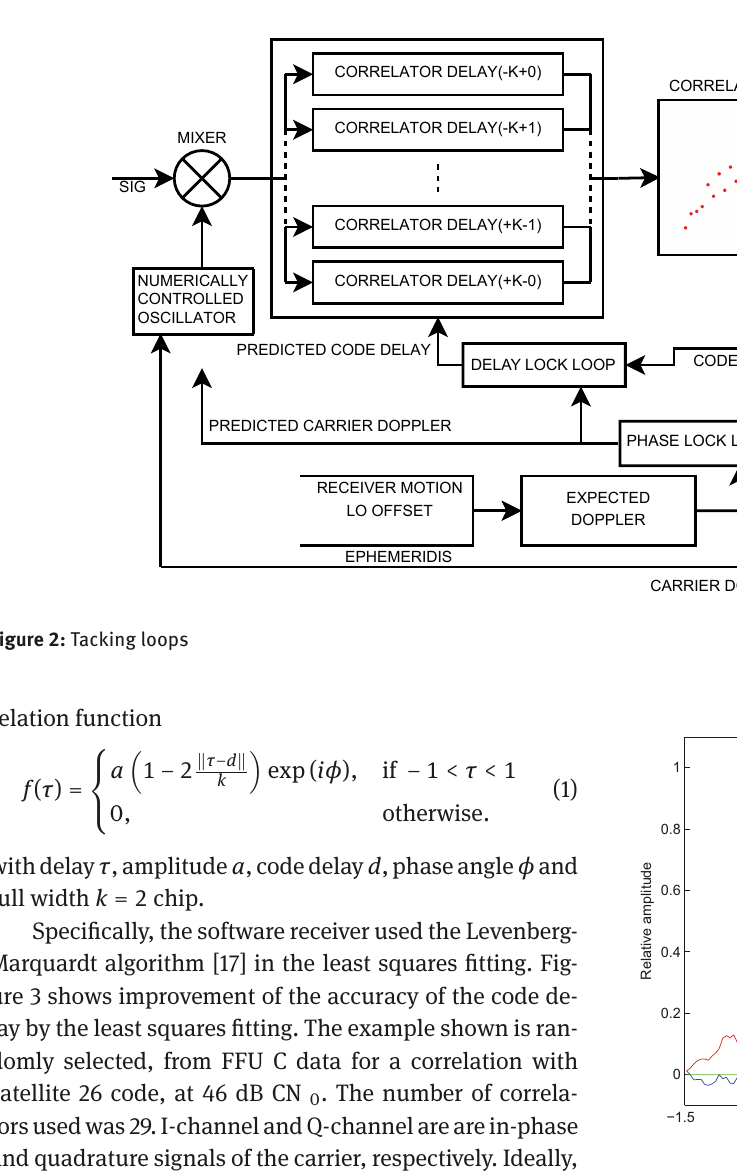
Figure 3: Code curve